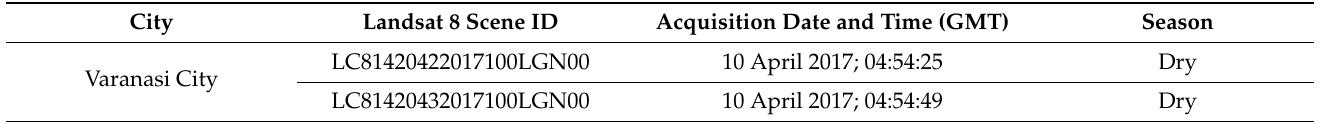
( a ) ( b ) Figure 1. ( a ) Location map of Varanasi city, India (study area). ( b ) White circle shows Varanasi city marked on Landsat 8. image. sat 8 OLI/TIRS) images were used. The images were acquired from https://earthexplorer. usgs.gov/ (accessed on 30 April 2017) and are shown in Table 1. These images have 11 bands, containing 8 multispectral bands (band 1st–7th and 9th), one panchromatic (band 8th), and two thermal bands (band 10th and 11th). Pre-processing of datasets was performed based on digital number (DN) of multispectral bands using the ArcMap 10.5. Table 1. Description of Landsat 8 image acquisition for Varanasi